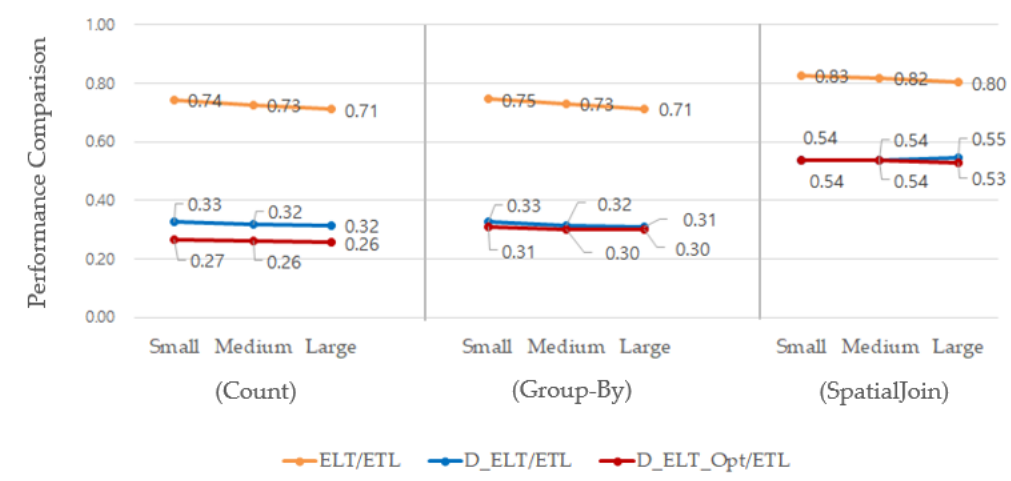
Figure 12. Overall performance comparison of ELT/ETL vs. D_ELT/ETL vs. optimized D_ELT/ETL based on a small, medium, and large data size for each of three analyses: Count, Group-By, and SpatialJoin.